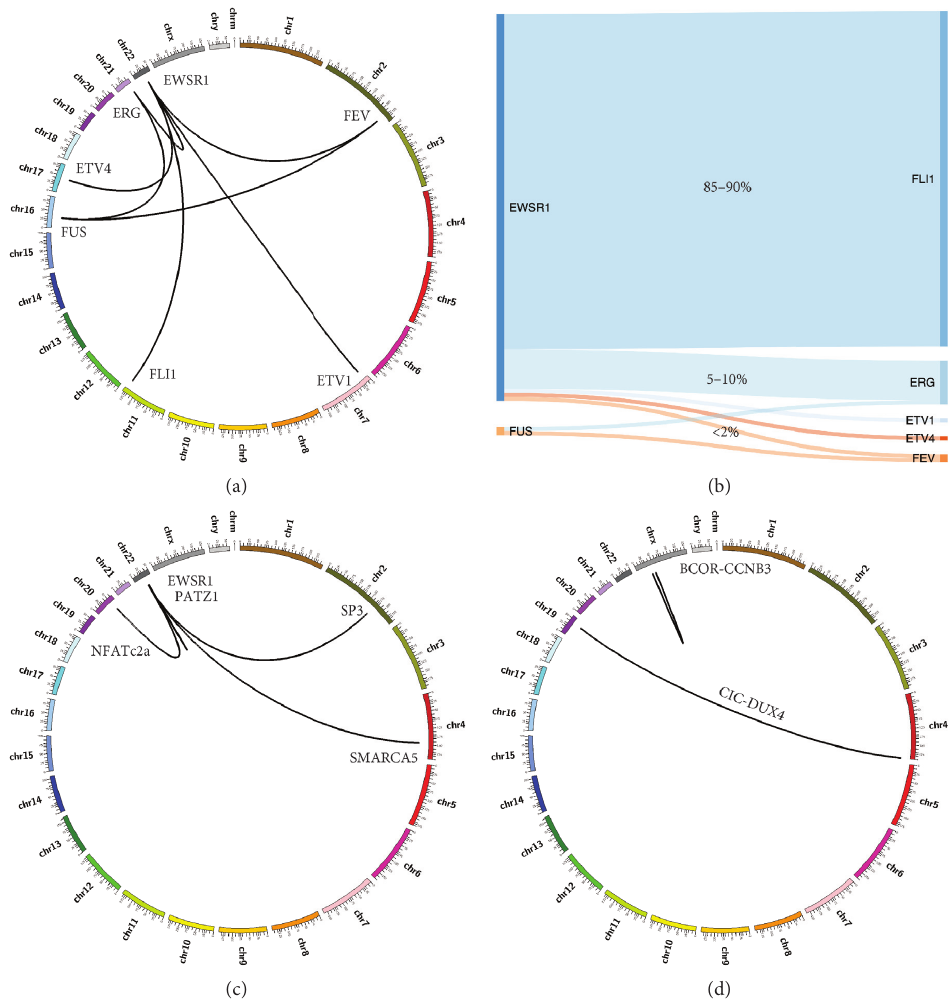
Figure 1: Proposed WHO Classification of Tumours of Soft Tissue and Bone for Ewing and Ewing-like sarcoma: (a) Circos plot of Ewing sarcoma with all FET-ETS variants. (b) Sankey plot of FET-ETS translocation Ewing sarcoma scaled to represent the percentage of total cases. (c) Circos plot of select EWSR1 round cell sarcomas with non-ETS partners. (d) Circos plot of two most common CIC and BCOR translocation